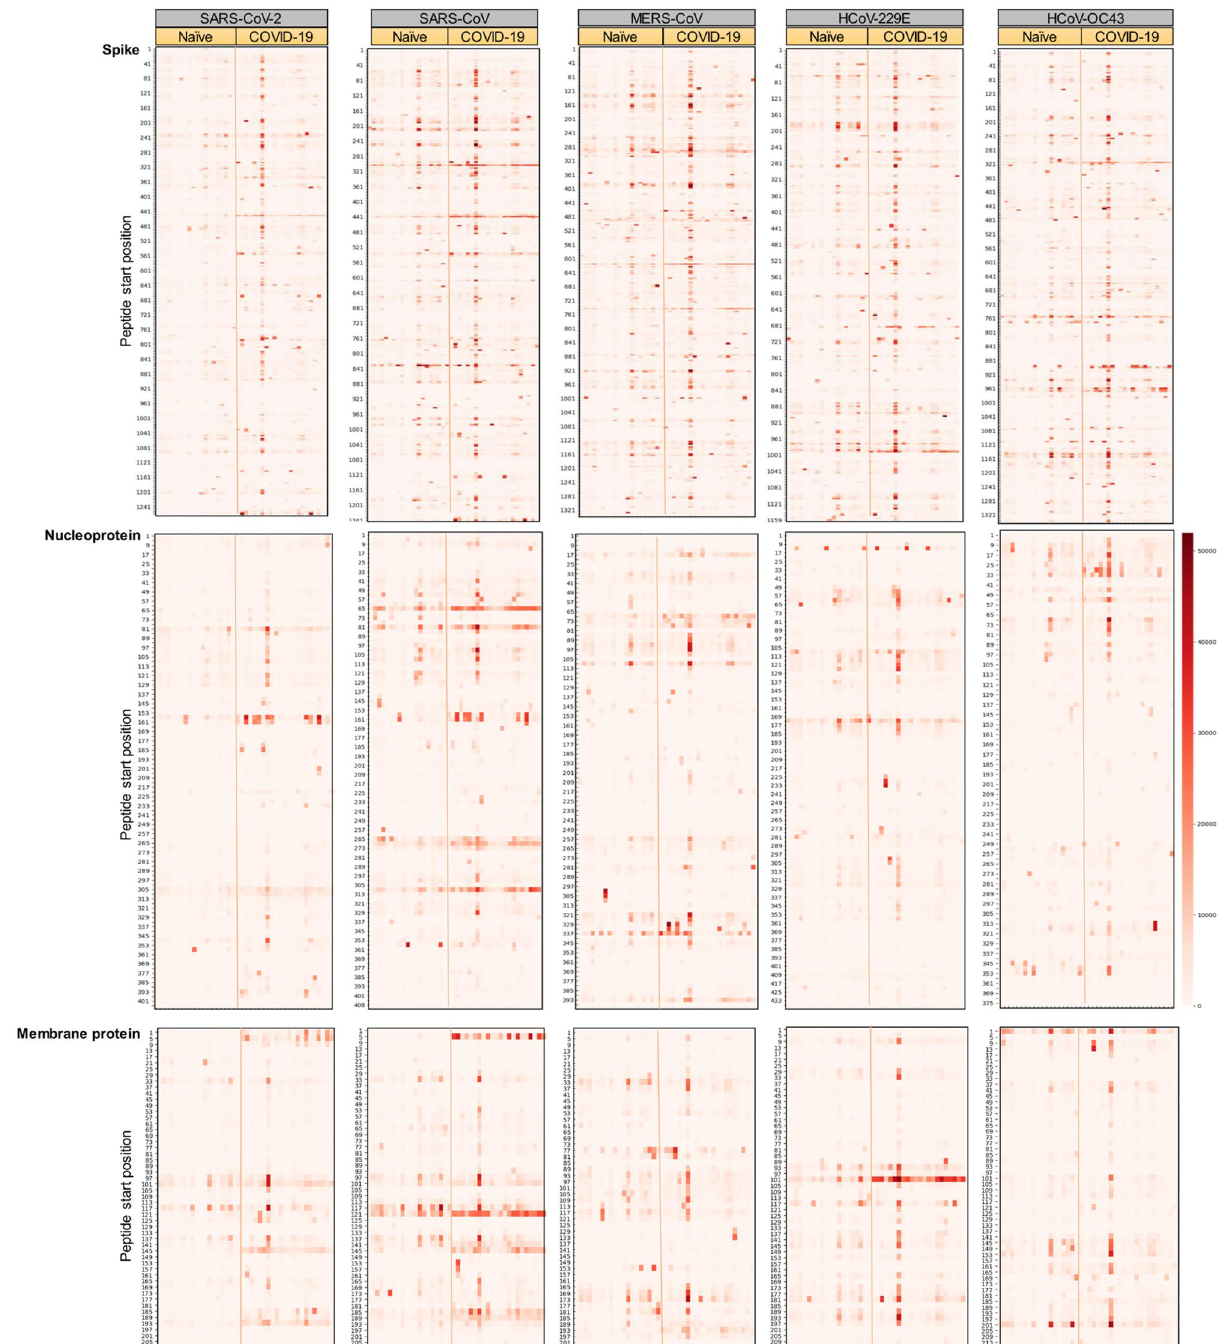
Figure 1. Long-term polyclonal antibodies following COVID-19 recognize multiple SARS-CoV-2 epitopes, and cross-react with related human coronaviruses. Heat-maps displaying the reactivity of COVID-19 convalescent sera collected at 5 months post-diagnosis (n = 22) and naïve sera (n = 20) to individual peptides of spike, nucleoprotein, and membrane protein. For each heat-map, the left and right panels show reactivity with naïve and COVID-19 convalescent sera, respectively. The y-axis represents the linear protein sequence arranged from N-terminus (top) to C-terminus